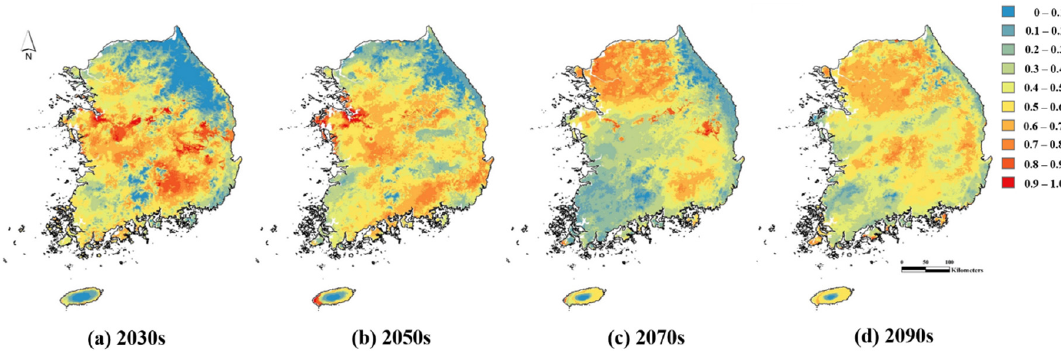
Figure 5. Future presence probability maps of R. shantungensis in Korea using MaxEnt: ( a ) 2030s; ( b ) 2050s; ( c ) 2070s; ( d ) 2090s.